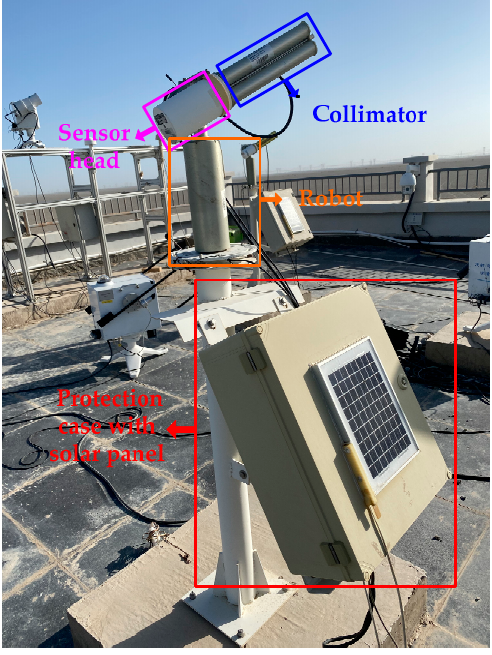
Figure 1. Sun photometer (CE318-T593) at the Dunhuang site.